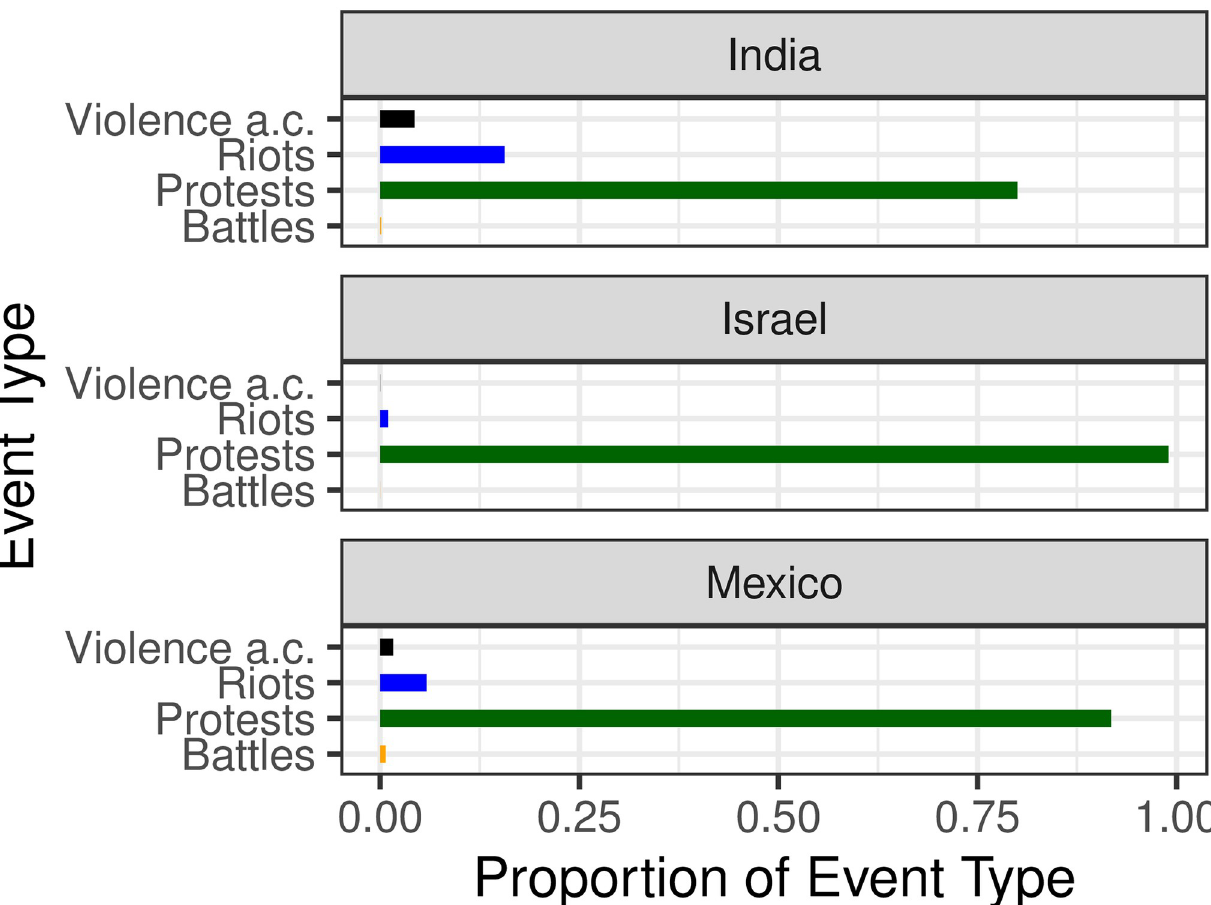
Fig 2. Event type distribution across India, Israel and Mexico as tallied from January 3 rd to December 12 th , 2020. “Violence a.c.” stands for “Violence against civilians”. The majority of events are protests, followed in smaller percentage by riots, violence against civilians, and battles respectively. ACLED also lists explosions, which are not reported in any of the countries under